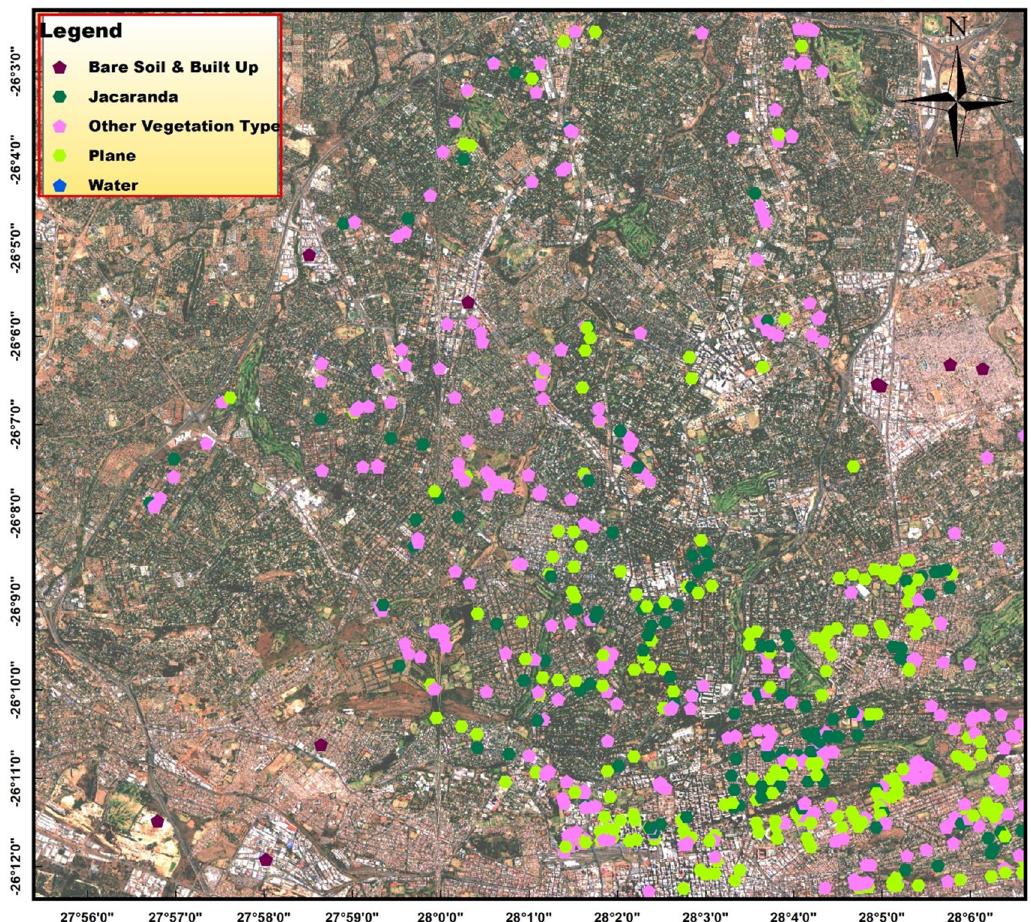
Figure 2. The distribution of the ground-truthing GPS points collected for mapping the distribution of two street trees, Jacaranda mimosifolia and Platanus × acerifolia (London Plane) and other land cover classes in the study area, the city of Johannesburg, South Africa, which includes the central business district (CBD), Randburg, Sandton, Houghton, Selby, Crown, and Fairland regions of the city as well as over half of the Alexandra township among others. The map was generated using the ArcGIS desktop software version 10.3 from SPOT 6 image obtained from the South African National Space Agency